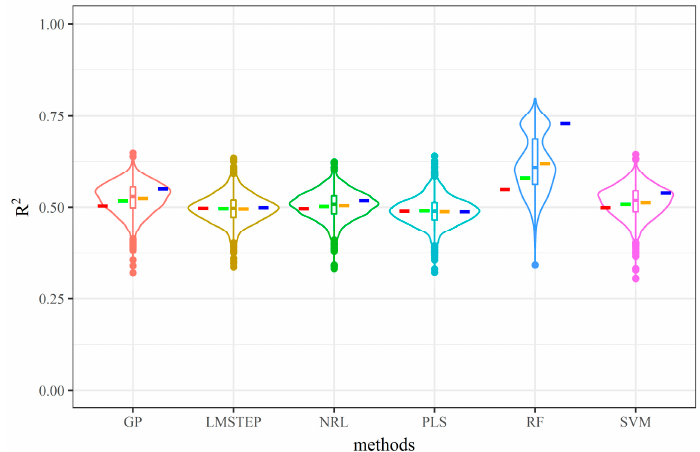
Figure 4. The distribution of R 2 values using different prediction approaches.